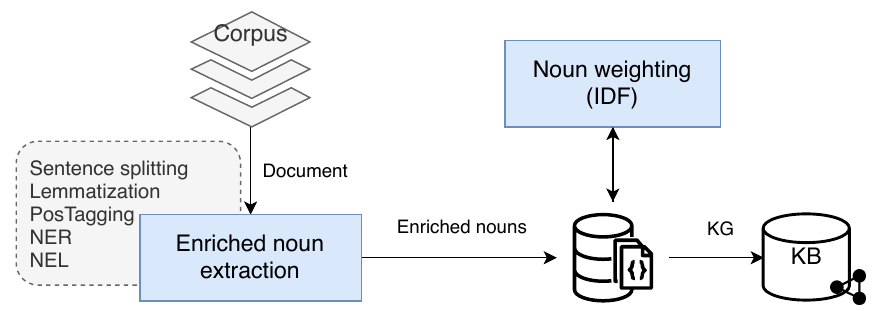
Figure 5. KRS generation steps, from a given document’s corpus.